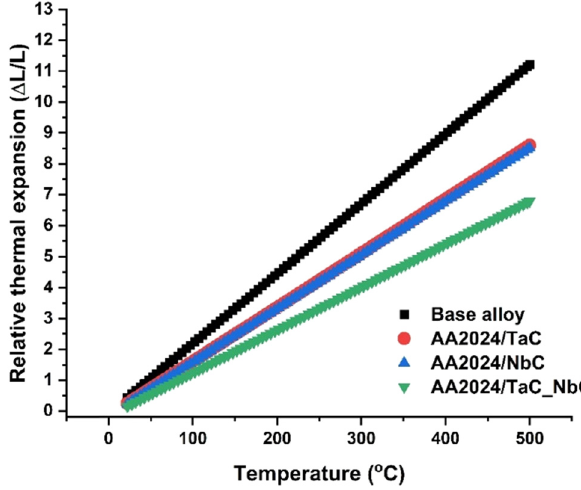
Figure 8: XRD patterns of AA2024, AA2024/TaC, AA2024/NbC, and AA2024/TaC_NbC.